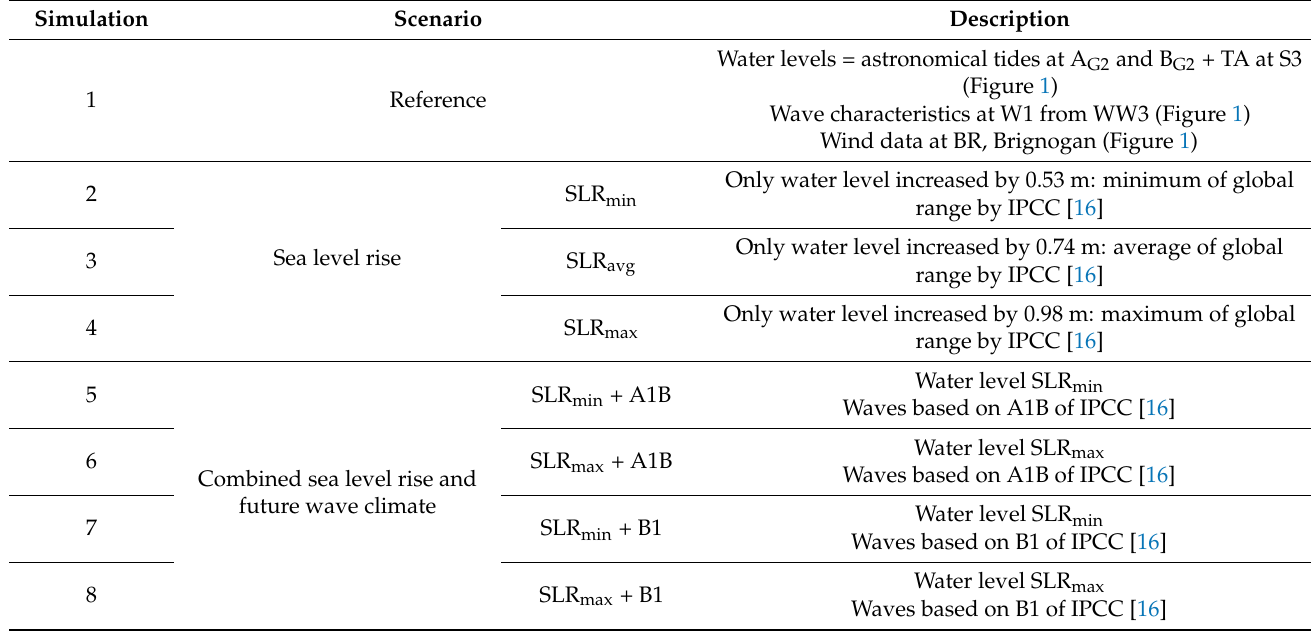
Table 2. Summary of the water level and wave conditions used in each model simulation: (1) reference time period from 7 January–18 February 2013 and projected simulations considering (2, 3, 4) SLR-only and (5, 6, 7, 8) four different combinations of SLR and projected wave